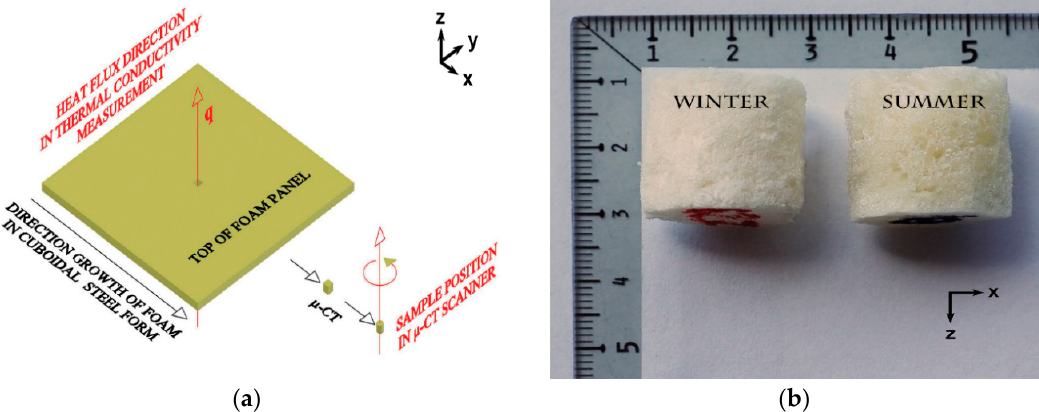
Figure 1. ( a ) Preparation of the sample for X ‐ ray computed microtomography (µ ‐ CT) measurement from the polyurethane (PU) panel: foam growth along the x ‐ axis, cutting a cuboidal, and further forming the cylindrical sample. The sample rotation in the µ ‐ CT scanner is shown around the z ‐ axis— parallel to vector q and perpendicular to the scanner holder in xy ‐ plane. In this figure, the sample to panel size ratio is kept the same as the original; ( b ) The enlarged WINTER (W)/SUMMER (S) foam samples are shown over the xz ‐ plane.